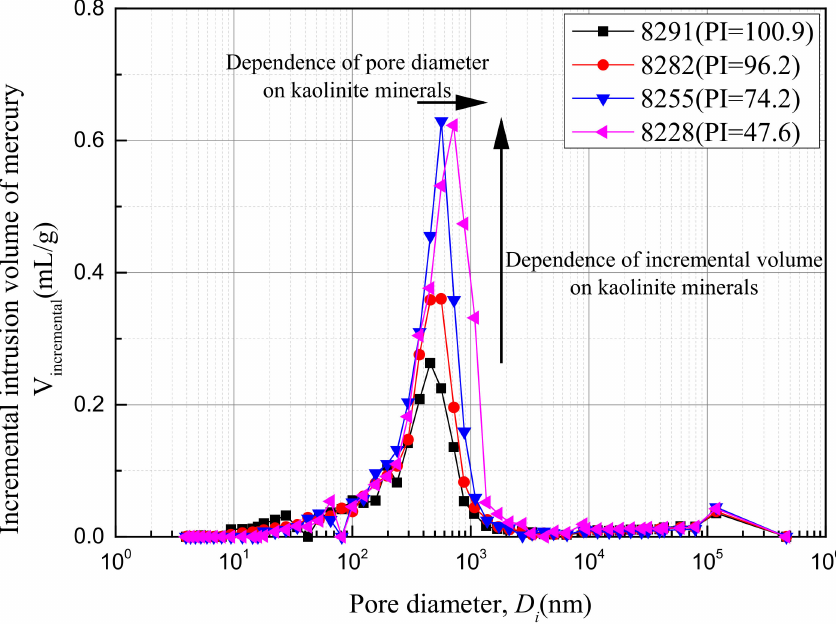
Figure 18. Pore-size distribution with respect to incremental intrusion volume of